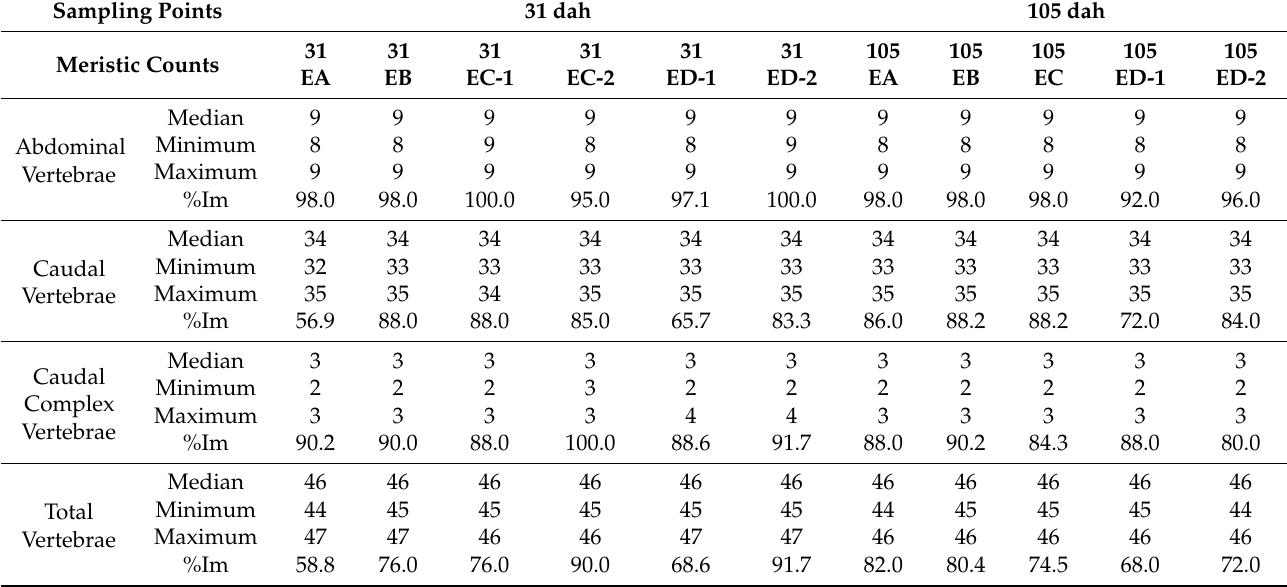
1 Medians with a different superscript letter denote significant differences in the distribution among dietary-tank groups for each sampling point (Kruskall-Wallis test, p < 0.05). Table 8. Number of vertebrae in abdominal, caudal, and caudal complex regions for each diet-tank group (31 EA, 31 EB, 31 EC-1, 31 EC-2, 31 ED-1, 31 ED-2, 105 EA, 105 EB, 105 EC, 105 ED-1, 105 ED-2): median, minimum, and maximum values and occurrences of individuals showing the median values (%Im). dah: days after